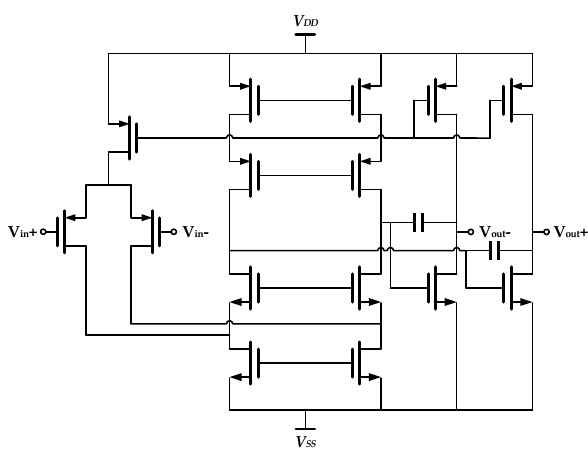
Figure 9. Schematic of OTA in the employed differential S/H.